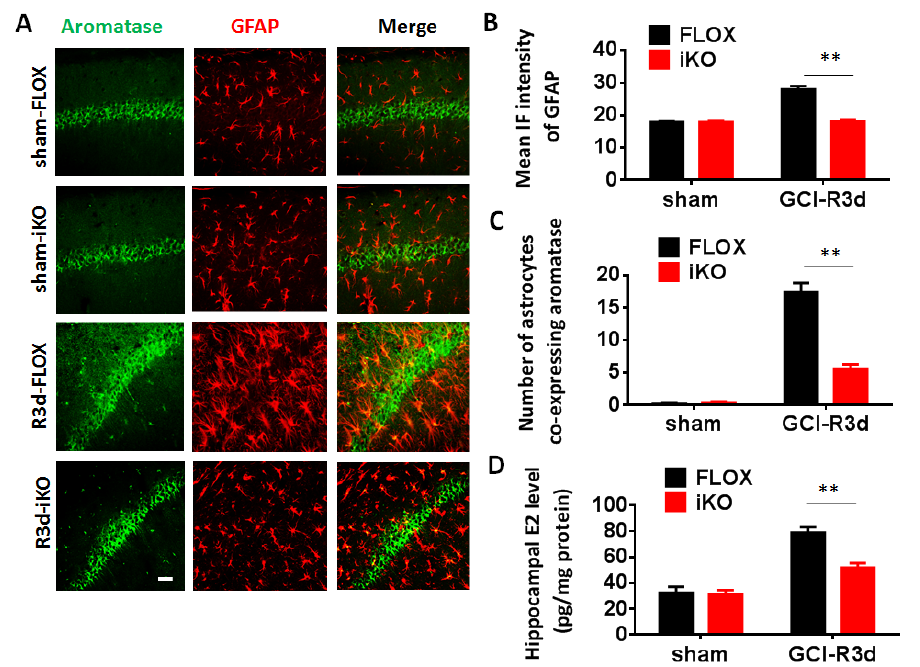
Figure 2. GFAP-ARO-iKO mice show significant diminishment of ischemia-induced aromatase expression in astrocytes, as well as reduced reactive astrocyte induction and hippocampal E 2 elevation after GCI. ( A ). Representative images for aromatase and GFAP immunostaining in the hippocampal CA1. ( B ). Quantification of GFAP immunofluorescent intensity in the sham or R3d hippocampal CA1 regions of male FLOX and iKO mice. ( C ). Quantification for the number of astrocytes expressing aromatase in the hippocampal CA1 regions of sham and R3d groups. ( D ). Hippocampal E2 levels were measured by ELISA assay on hippocampal tissues from sham and R3d FLOX and iKO mice in male animals. n = 6–8 animals/group. Scale bars: 20 µm. ** p < 0.01 compared to FLOX, two-way ANOVA followed by post hoc.